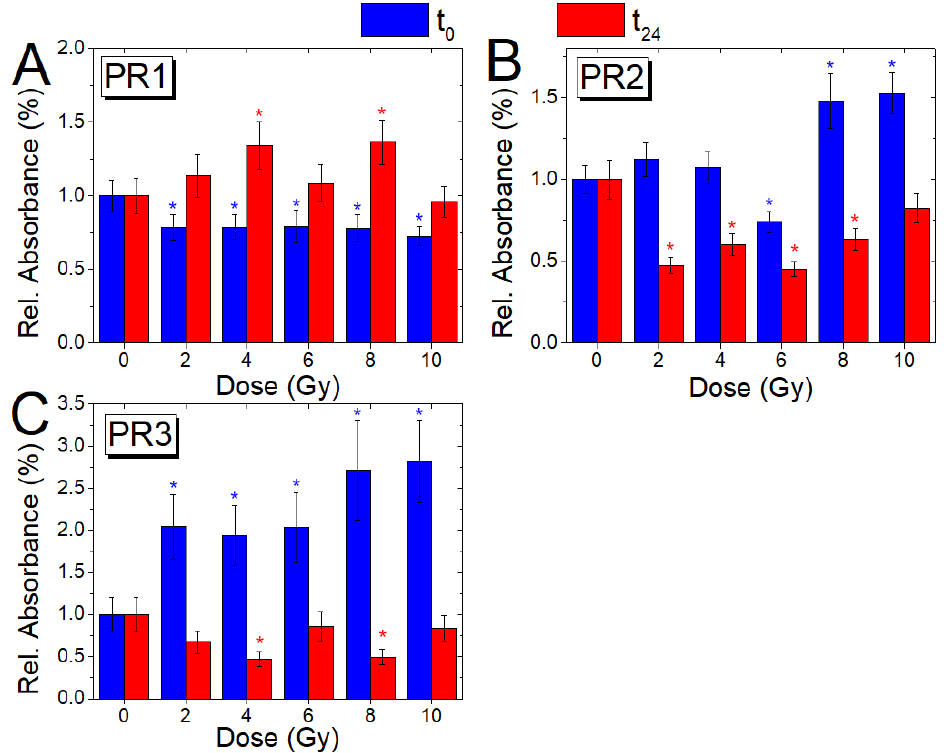
Figure 5. Comparison of the absorbance ratios PR1 ( A ), PR2 ( B ), and PR3 ( C ) with dose, for cells fixed immediately (blue) and 24 h after irradiation (red); the ratio variations (Mean ± SD) are reported, as a value normalized with respect to the corresponding ratio value of the non-irradiated samples (0 Gy, t 0 ; 0 Gy, t 24 ); blue and red asterisks indicate when a significant difference in respect to the control value for the t 0 and t 24 samples, respectively, occurred at p ≤ 0.05 .